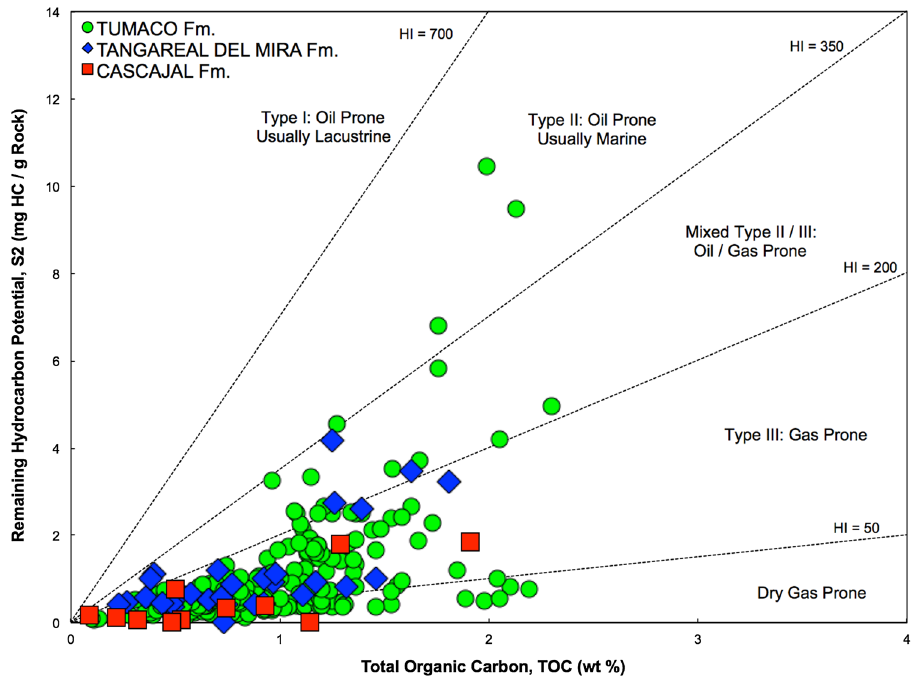
Fig. 5 Kerogen type (pseudo van Krevelen diagram) using S2 peak (mg HC/g rock) versus present-day TOC,